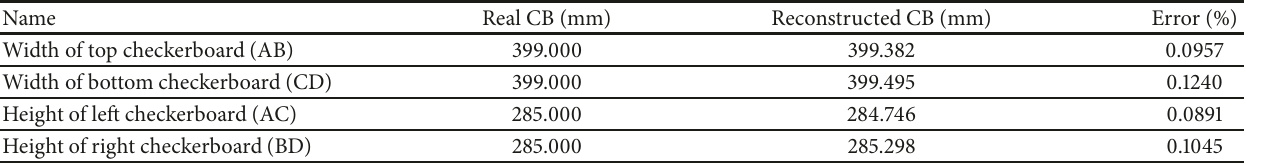
Table 1: Measuring the accuracy of a reconstructed checkerboard (CB) as shown in Figure 10.